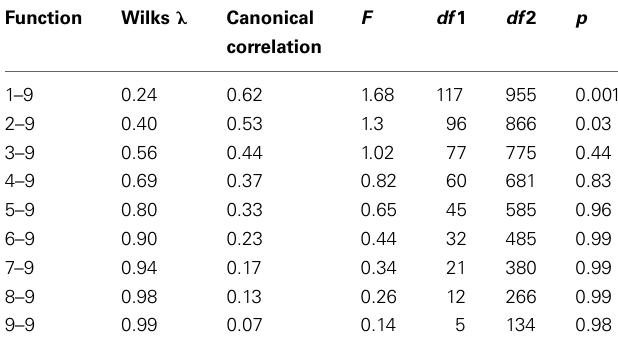
Table 3 | Tests of canonical